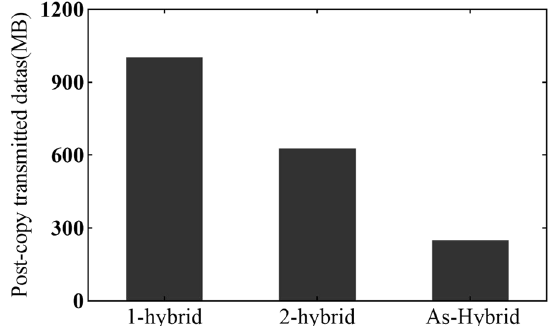
Fig. 9 Transferred data during post-copy